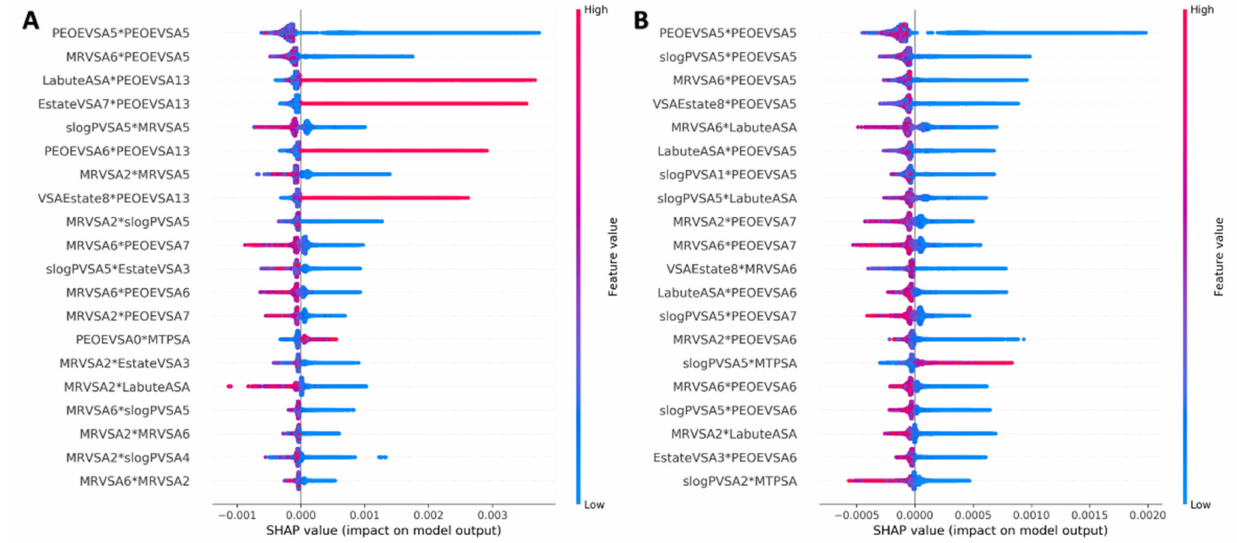
Figure 3. Shap summary plot of top 20 important features ranked by BestFit method ( A ) and Random Forest method ( B